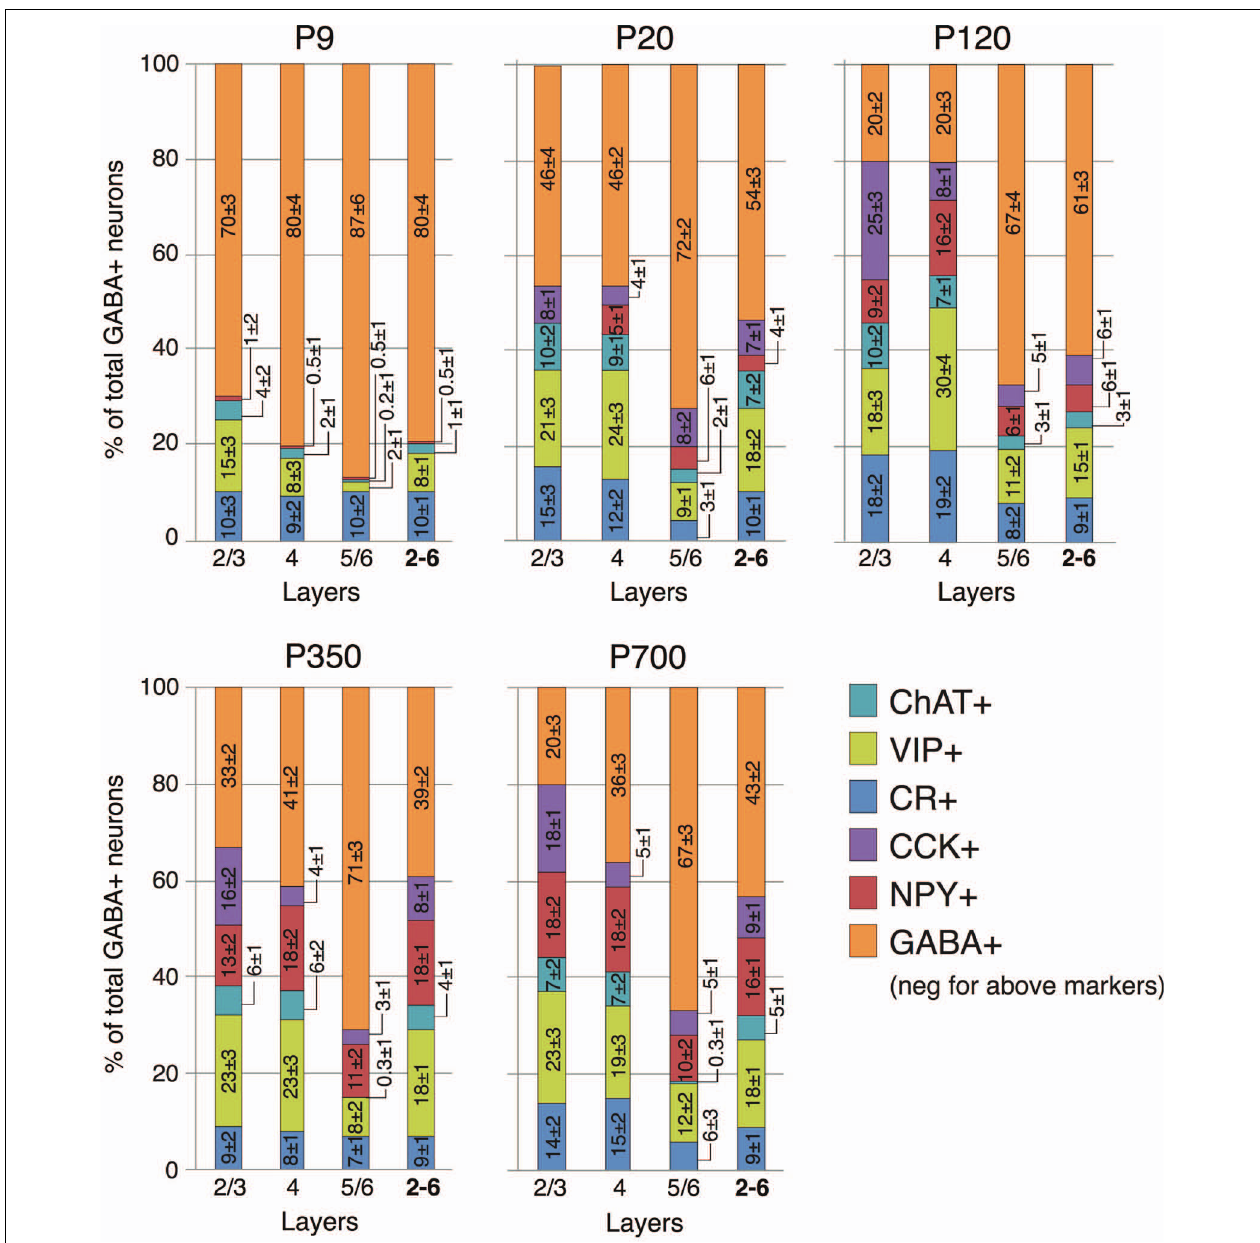
FIGURE 5 | Laminar distribution of CR, VIP, ChAT, NPY, and CCK neuron markers according to age. Numbers represent the percentage of cells immunostained for the various interneuron markers relative to the total